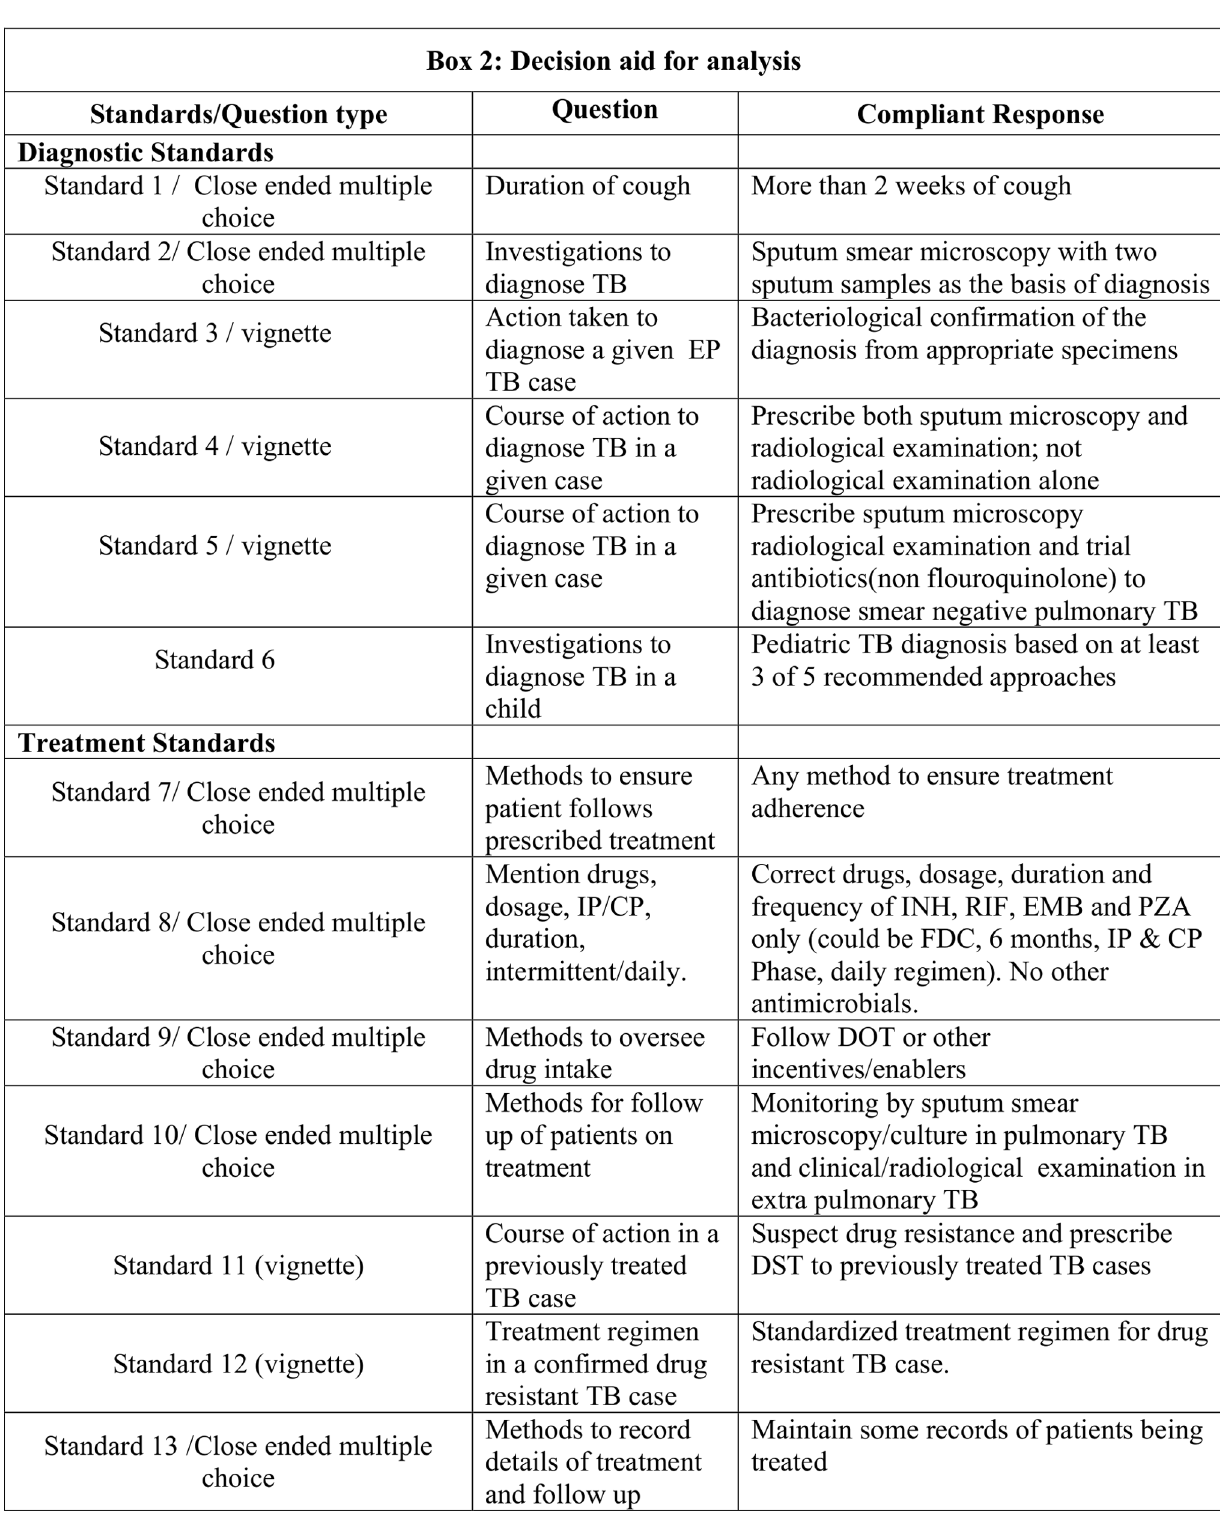
Figure 2. Box 2- Decision aid for analysis. This is a decision aid for the purpose of analysis of data; the type of question asked in the questionnaire, subject of the question and the responses which should be considered as compliant against each diagnostic and treatment standard are summarized.